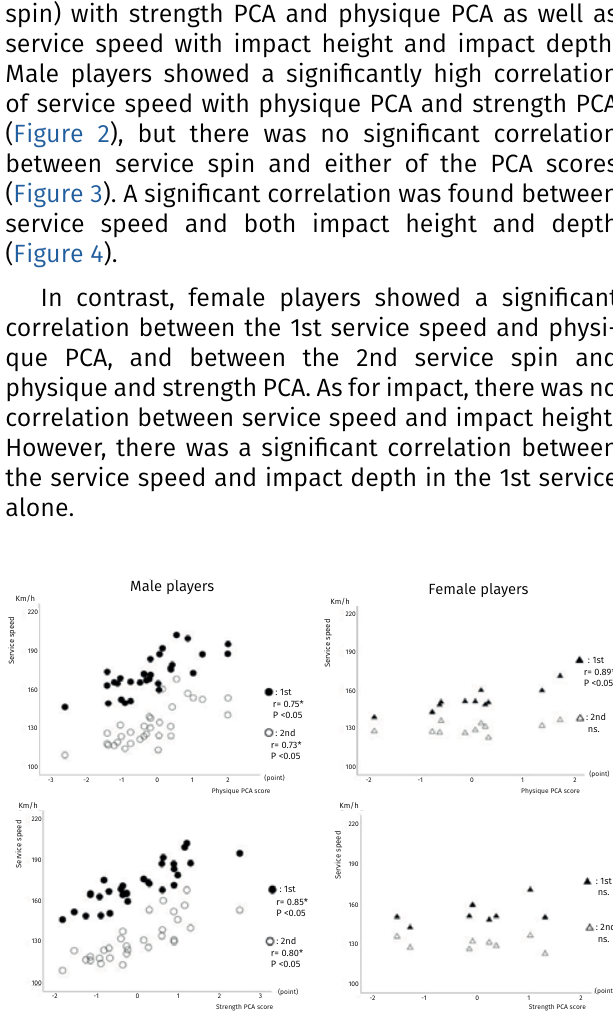
Figure 2. Correlation between service speed and physique PCA (upper row), and between service speed and physical strength PCA (bottom row) in male and female players. PCA: the first principal component analysis score.